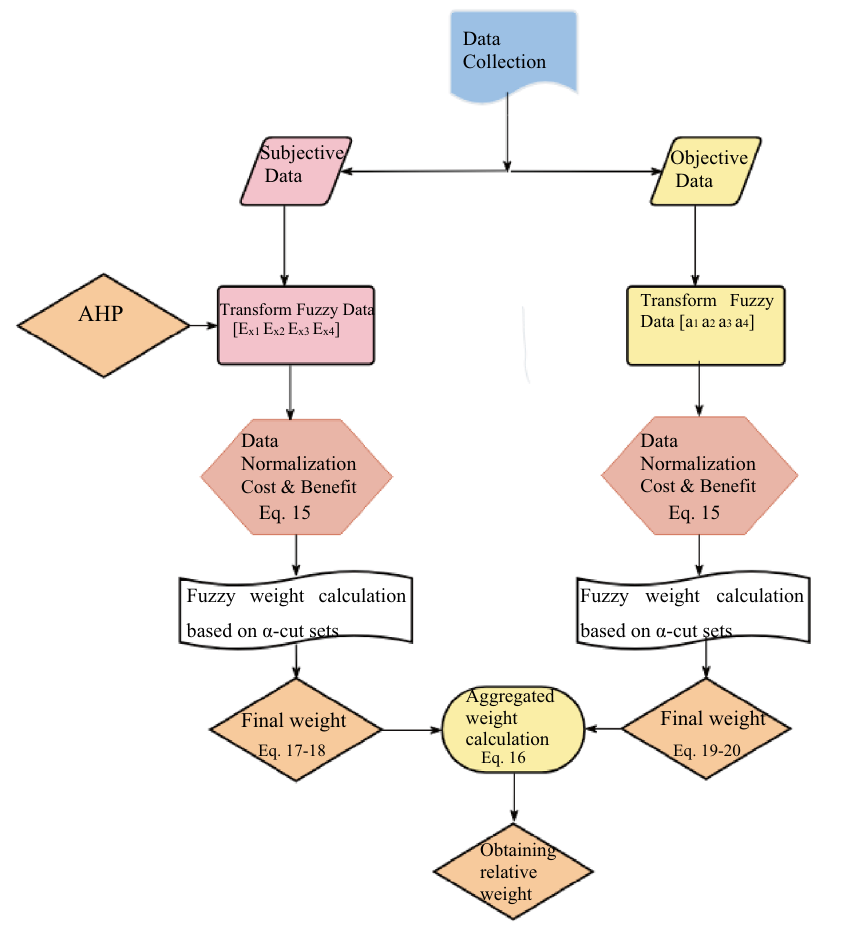
Figure 3. Creation of the weighted decision